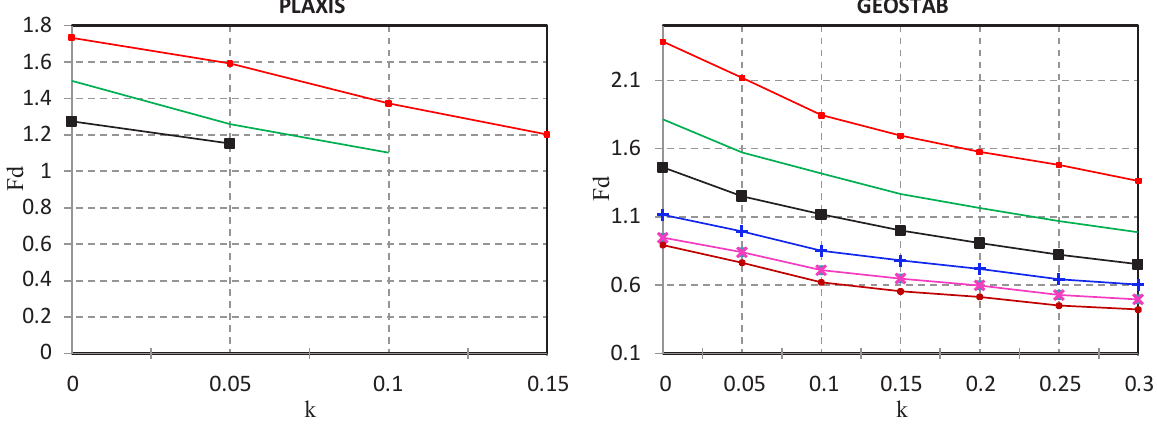
Figure 13: Effect of dam’s height.